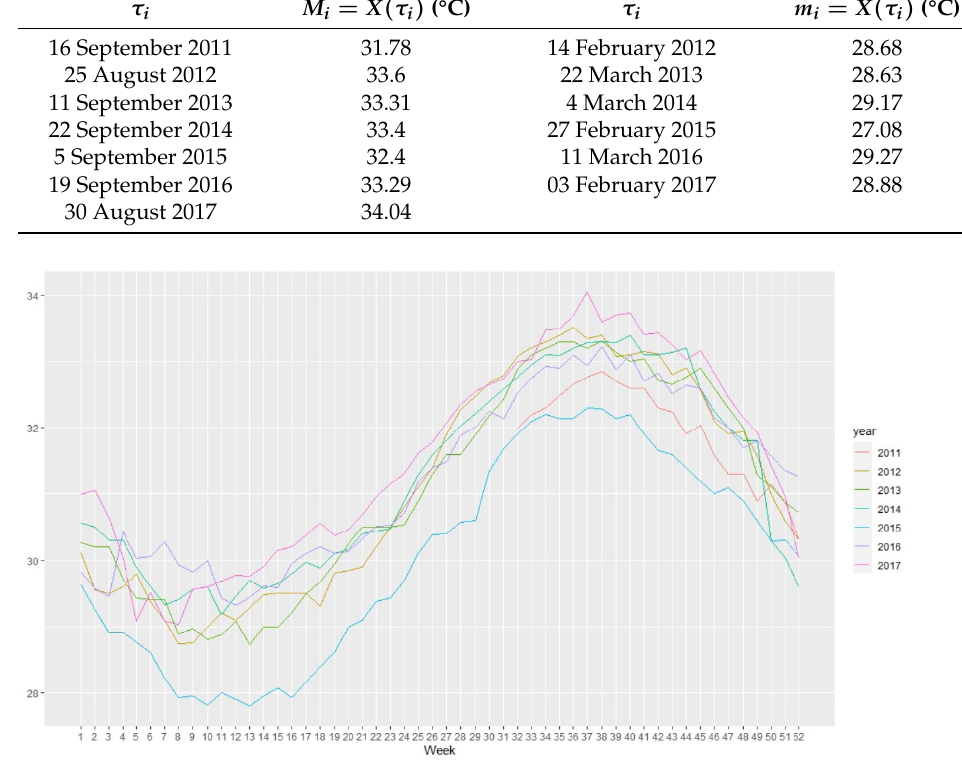
Figure 2. Seasonal plot of the temperatures described by X ( t ) . This was obtained by taking weekly spaced values from the time series X ( t ) and representing each year of observation (2011–2017) separately.